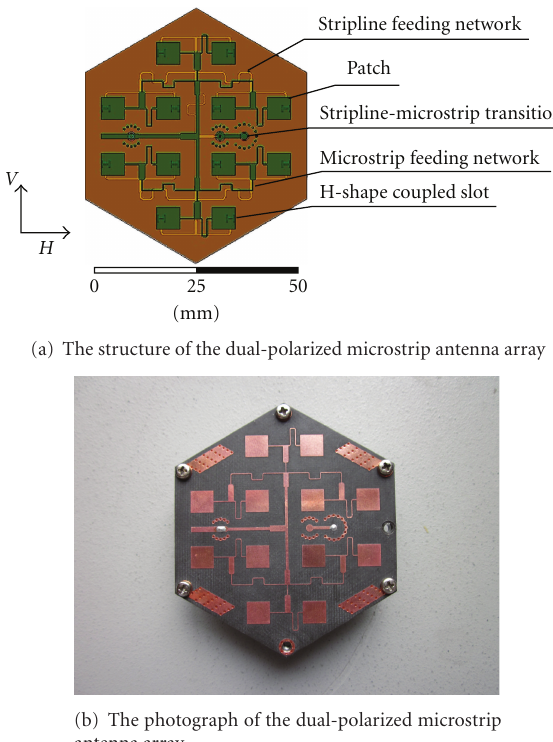
Figure 3: Dual-polarized microstrip antenna array.